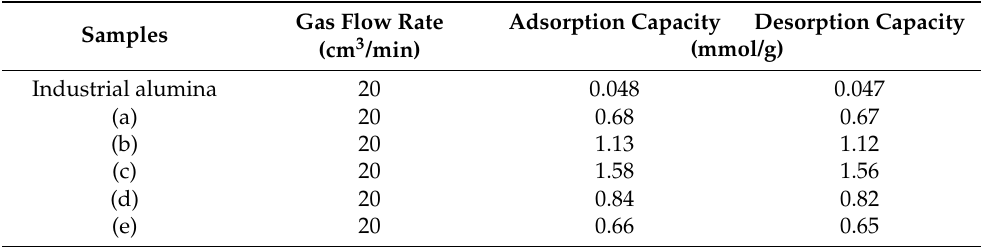
Table 3. CO 2 adsorption–desorption performance of industrial alumina and MA prepared in